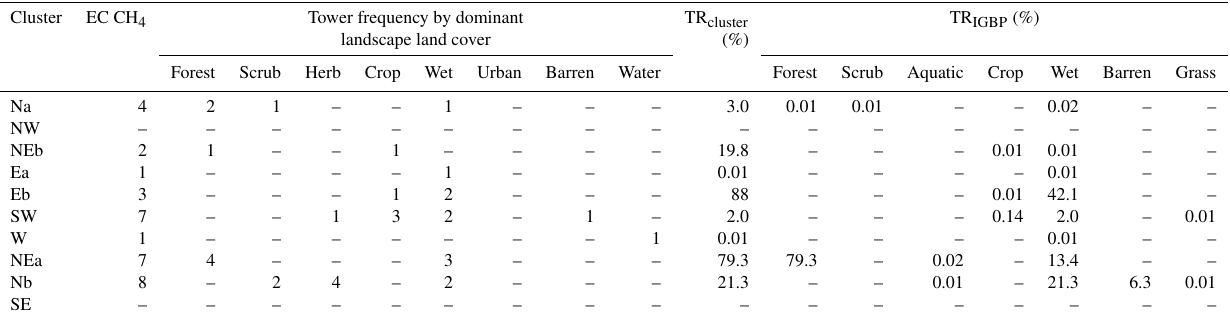
Table 3. The total number of eddy covariance (EC) towers measuring CH 4 and providing data to AmeriFlux. The tower frequency by dominant landscape type, the total cluster representativeness (TR cluster ), and cluster representativeness by major ecosystem types are shown (TR IGBP ). For TR cluster and TR IGBP values of 0.01 were assigned where a single tower was present.